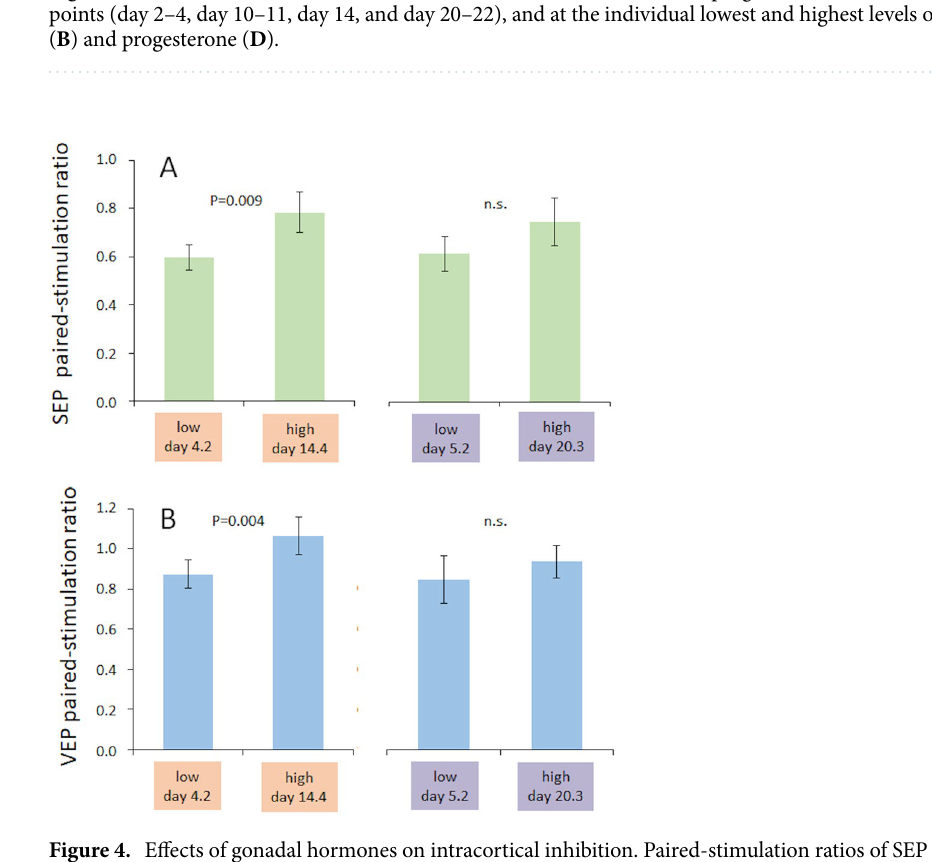
Figure 4. Effects of gonadal hormones on intracortical inhibition. Paired-stimulation ratios of SEP ( A ) and VEP ( B ) at individual lowest and highest levels of estradiol (left) and progesterone (right). Data are represented as mean ±